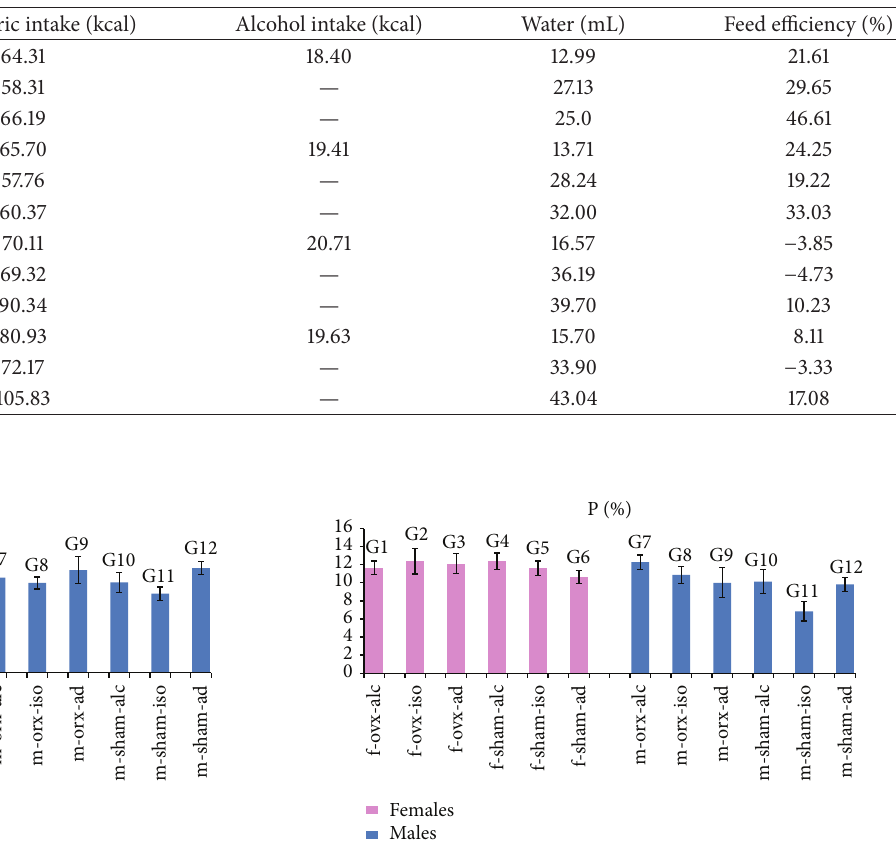
Figure 2: Ca (%): the graph illustrates the values of the averages (bars) and standard deviations (lines superimposing the bars).